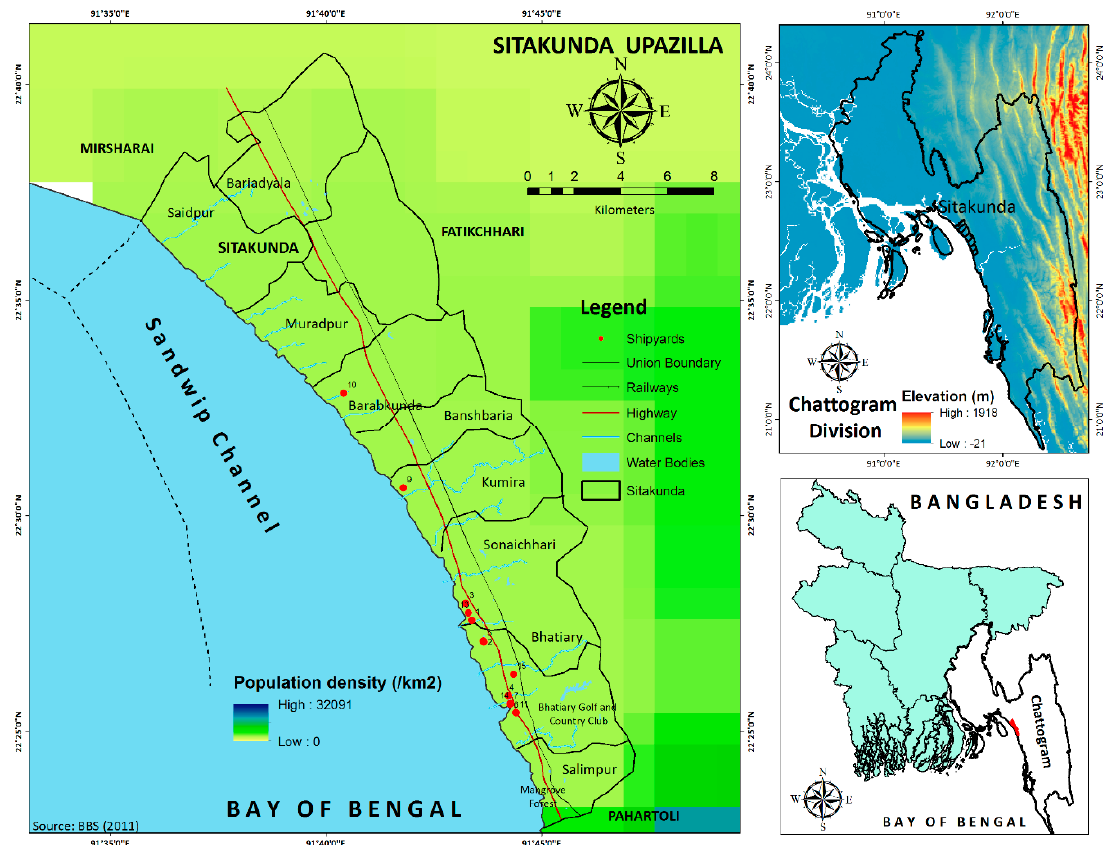
Figure 1. Map of Sitakunda showing the shipyards’ locations and the population density of that area (the red dots represent the shipyards).